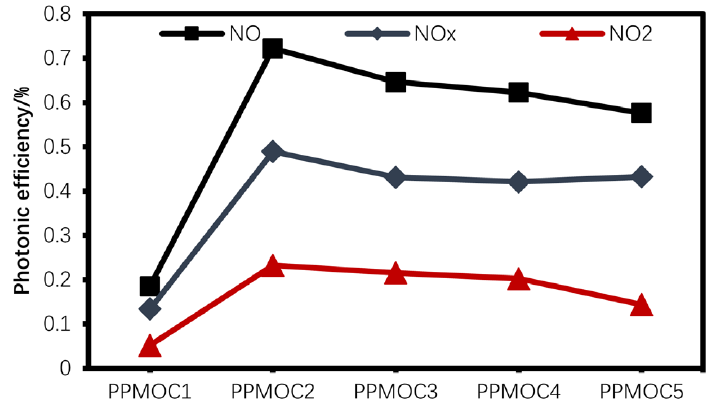
Figure 5. Photonic efficiency ( ξ ) of NO and NO x removal and intermediate product NO 2 formation of loading PPMOC once. The PPMOC number in x axis means different porosity (shown in the experimental section).